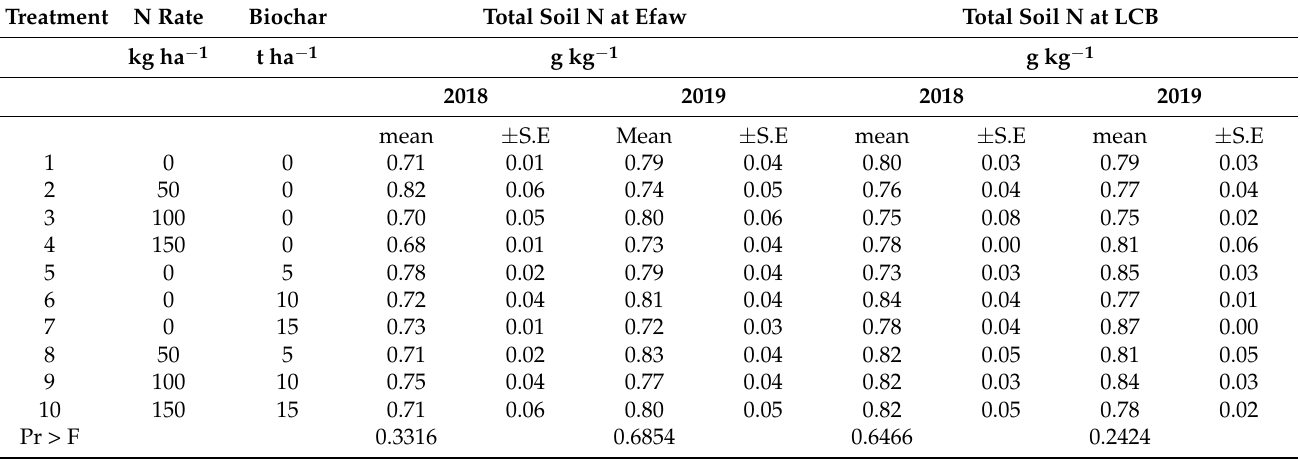
Table 5. Mean total soil N for treatments plus the associated contrasts between N fertilizer and biochar-N combinations at Efaw and Lake Carl Blackwell, Stillwater, Oklahoma. 2018 and